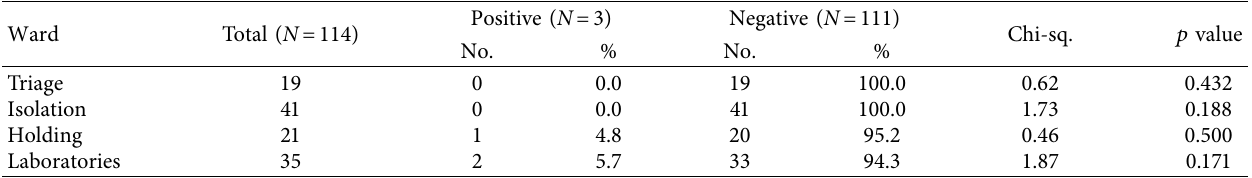
Table 8: IgG positive amongst different COVID-19 duty areas.